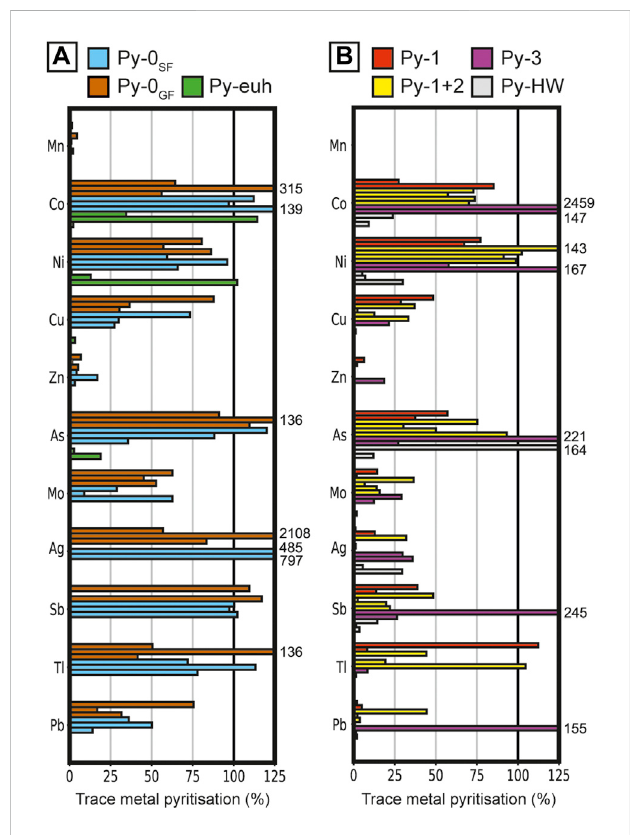
FIGURE 12 The degree of trace metal pyritization for samples with dominantly n = 3 for each sub-type), and (B) Py-1 (A) Py-0 SF , Py-0 GF , and Py-euh ( ( n = 2), Py-1+2 ( n = 4), Py-3 ( n = 2), and Py-HW ( n =